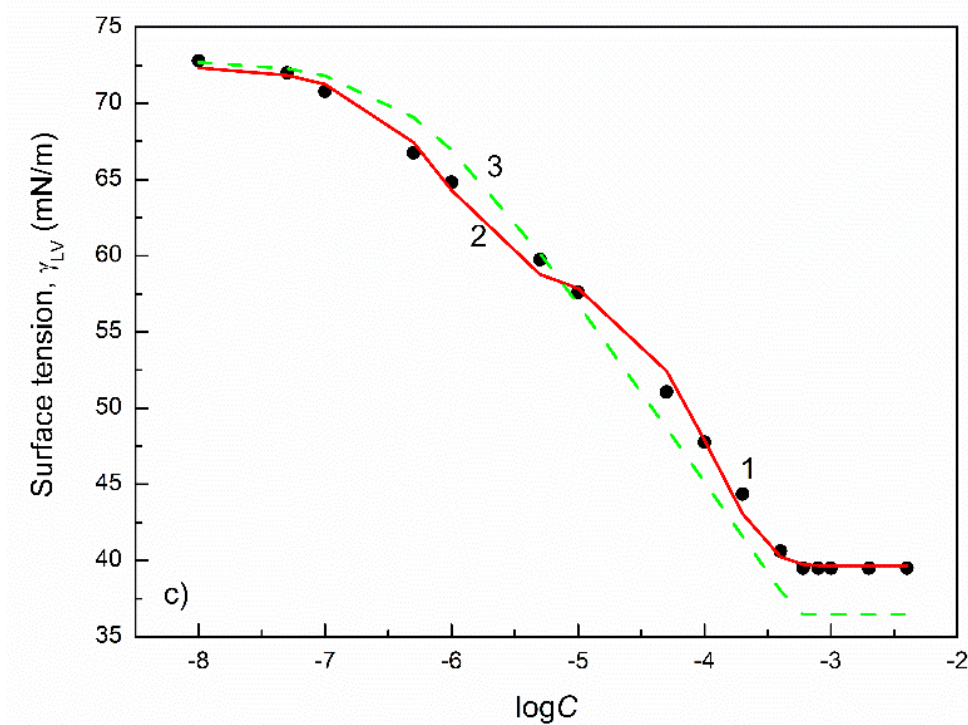
Figure 3. A plot of the surface tension ( γ LV ) of the aqueous solutions of TX100 ( a ), TX114 ( b ) and TX165 ( c ) vs. the logarithm of their concentration ( logC ). Points 1 correspond to the measured values [32], curves 2 and 3 correspond to the values calculated from the exponential function of the second order (Equation (2)) and Szyszkowski equation (Equation (3)), respectively.